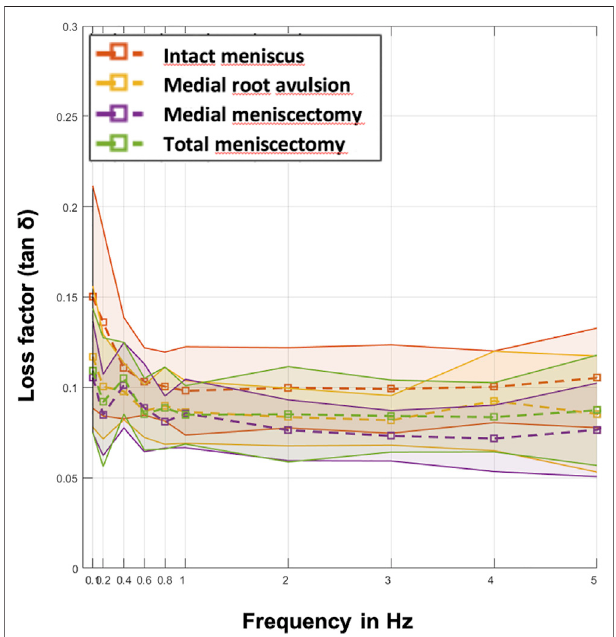
FIGURE 7 | Mean values (dashed lines) of the loss factor (tan δ ) ± SD (represented by the envelope in the same color) plotted over the ten investigatedfrequencies(0.1,0.2,0.4,0.6,0.8,1,2,3,4,and5 Hz)atthefour meniscal states (red: intact menisci; yellow: avulsion of the posterior medial meniscus horn; purple: medial meniscectomy; green: total lateral and medial meniscectomy). n = 8.